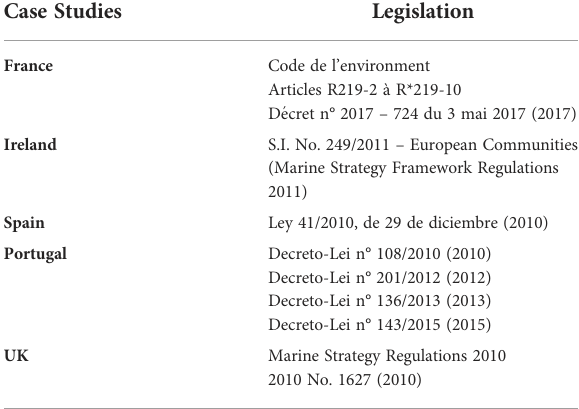
TABLE 2 Adopted legislation of each case study, regarding the